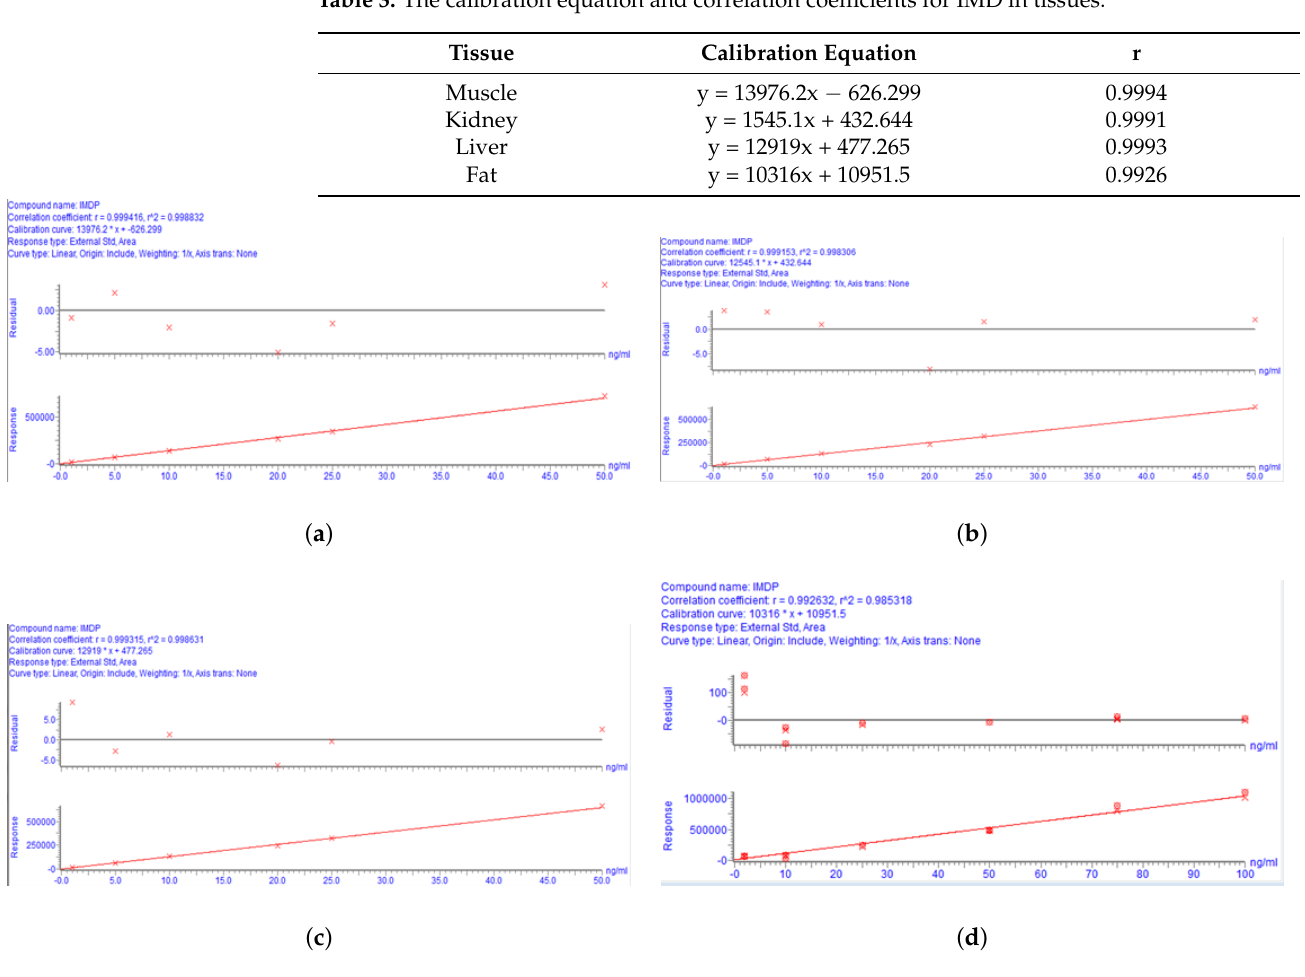
Table 3. The calibration equation and correlation coefficients for IMD in tissues.